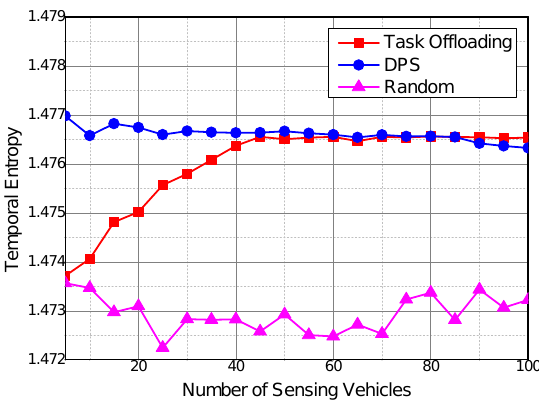
Figure 9. Temporal entropy with different numbers of sensing